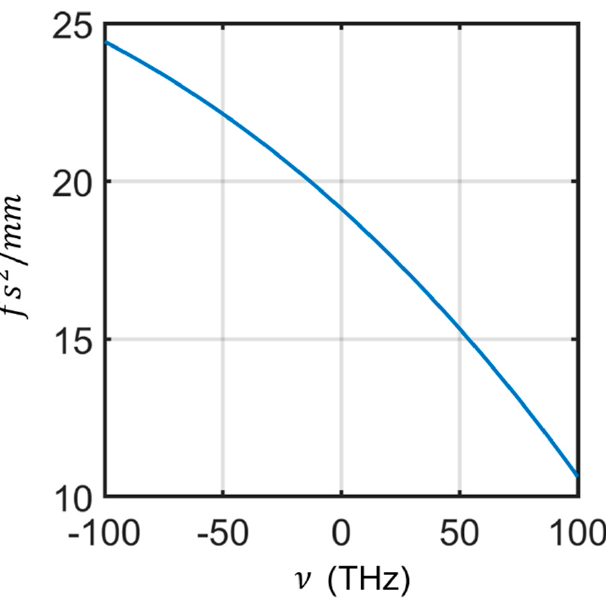
Figure 2. Group velocity dispersion in fs 2 /mm plotted with respect to envelope angular frequencies, across the bandwidth range of interest in an example normal dispersion fiber (Corning hi1060flex). Error in Figure 4